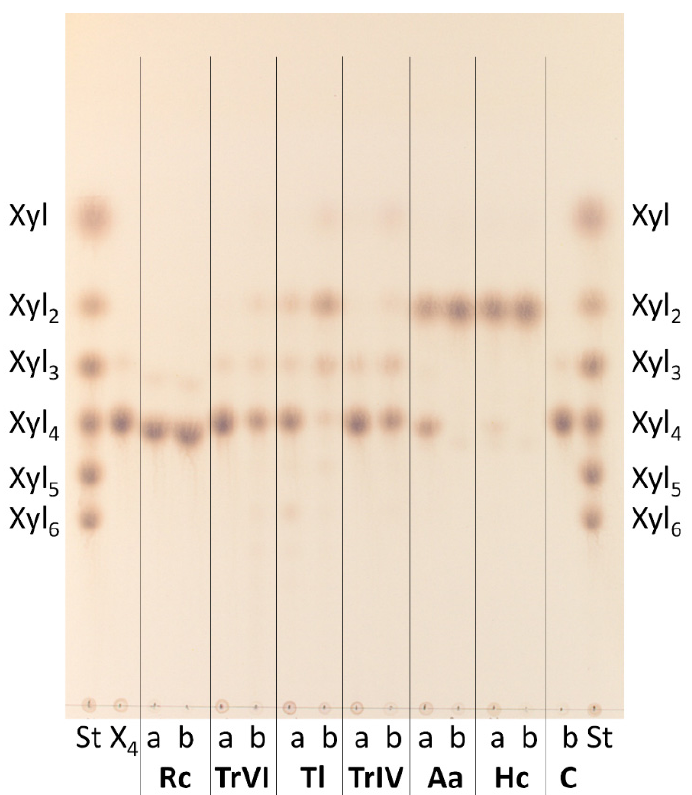
Figure 6. TLC analysis of hydrolysis products of Xyl 4 generated by GH30 xylanases. St—standards of linear XOs, a—15 min hydrolysate, b—24 h hydrolysate, C—Xyl 4 control without any enzyme incubated for 24 h.